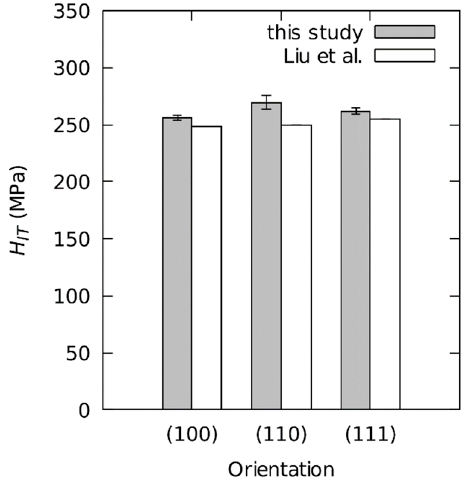
Figure 5. Indentation curves produced with the 6 × 6 arrays on differently oriented Al single crystal